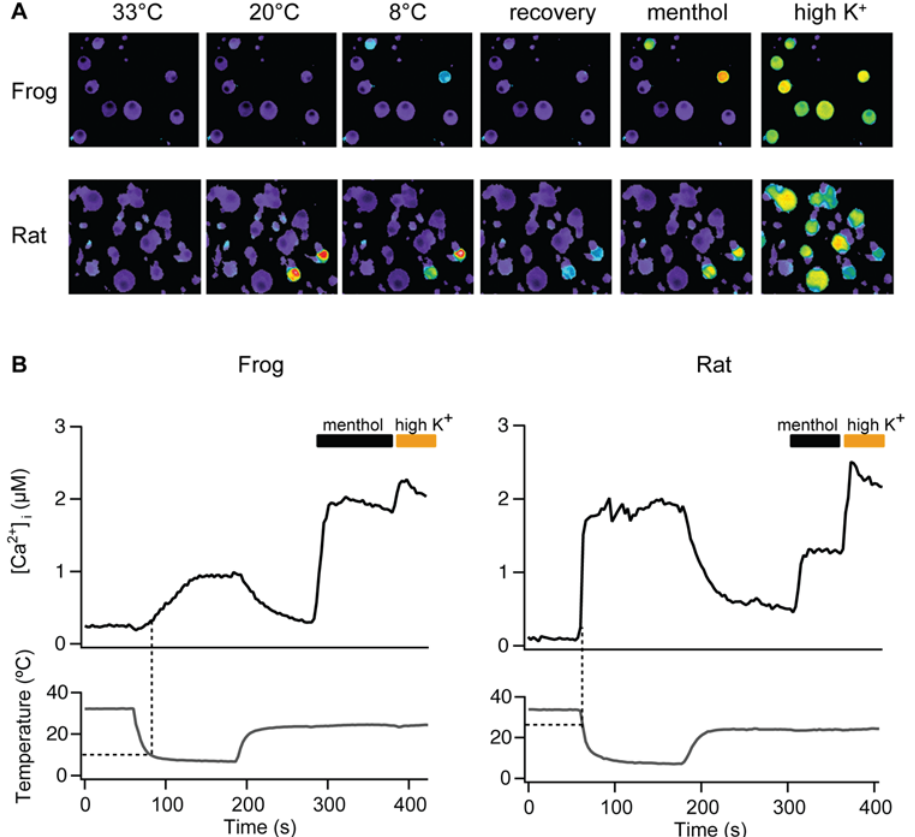
Figure 1. Differences in temperature preference for frog versus rat are reflected in differential cold sensitivity of primary afferent neurons. ( A ) Dissociated DRG neurons from X. laevis frogs or rats were exposed to a cold ramp (33 u C–7 u C) and responses measured by ratiometric calcium imaging. After a recovery period at 25 u C, cells were challenged with menthol (500 m M), followed by high extracellular potassium (70 mM KCl) to depolarize and identify all excitable cells. Note differential sensitivity of frog and rat neurons to 20 u C stimulus. ( B ) Averaged trace of calcium signals from menthol-resopnsive rat or frog DRG neurons stimulated as described in (A). Dotted lines indicate respective cold activation thresholds (9.6 6 0.6 u C for frog and 25.4 6 1.3 u C for rat) (n=30–40 cells). Cells showing an increase in intracellular calcium greater than five standard deviations above baseline fluctuations were taken as positive responders.